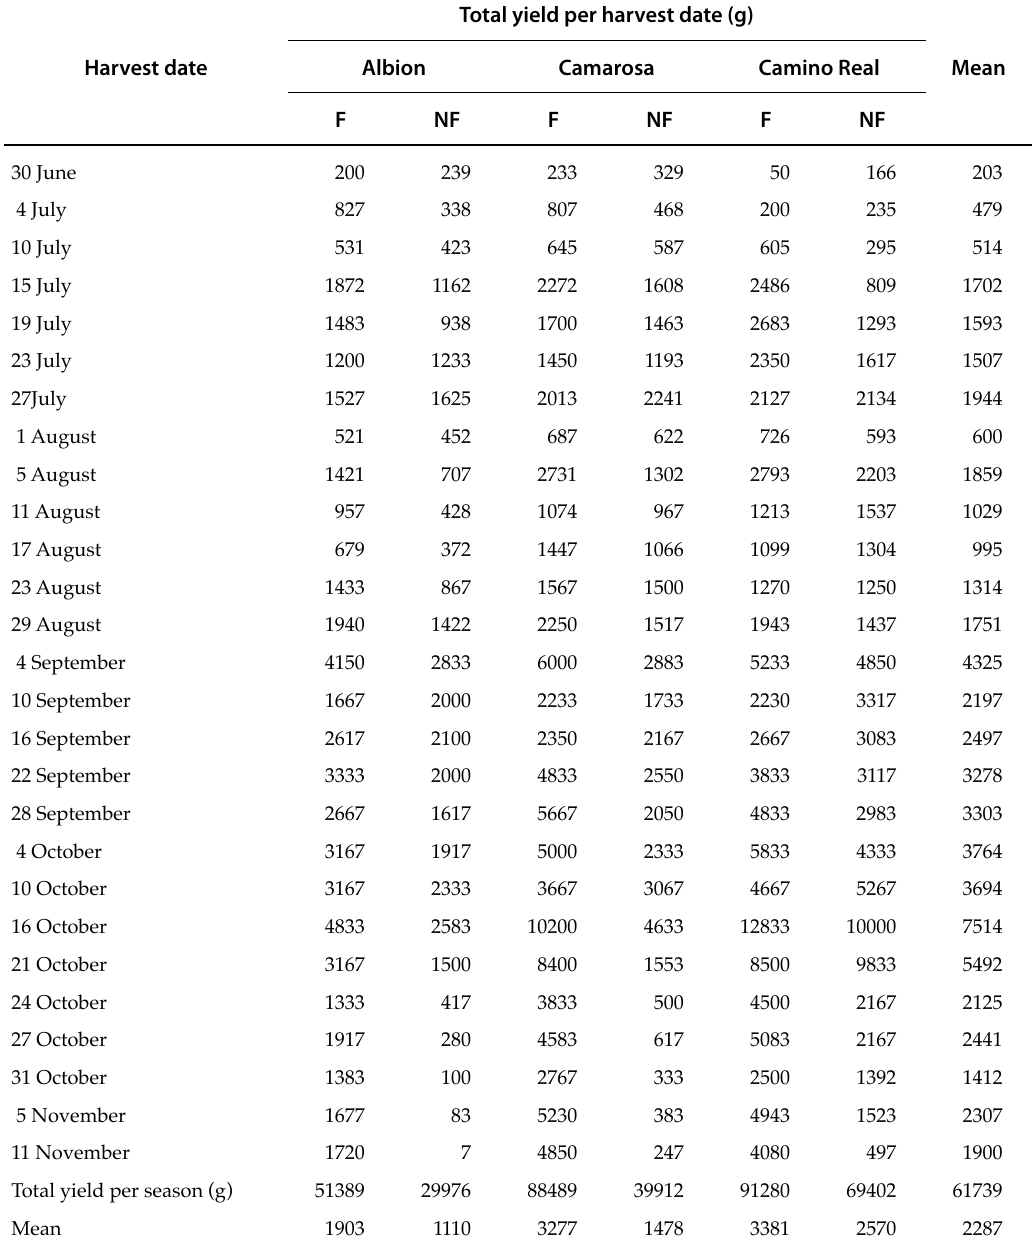
Table 1. Yields of strawberry cultivars for fumigated (F) and non-fumigated (NF) field beds (100 plants per bed) harvested at 3‒5 d intervals from 30 June to 11th November 2008 in the field experiments in Wanneroo, Western Australia. Total yield per harvest date (g) Harvest date MeanAlbion Camarosa Camino